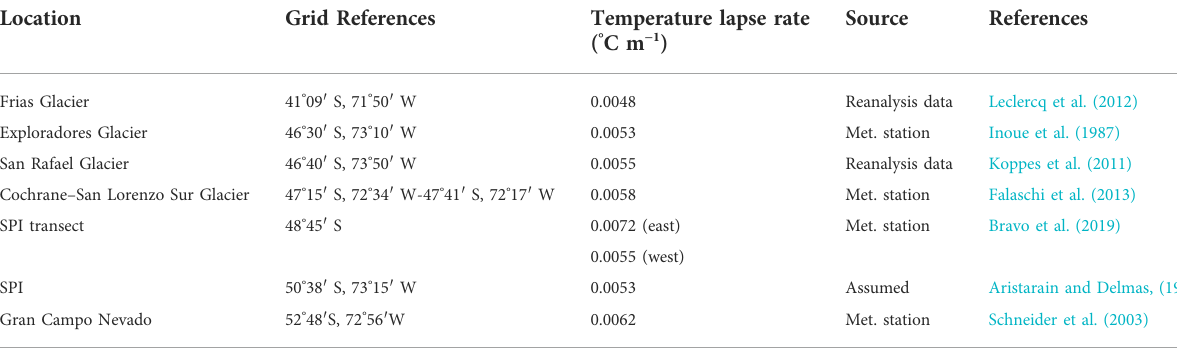
TABLE 1 Observed temperaturelapse rates fromacross Patagonia.Lapse rate from Cochrane toSan Lorenzo Glacier calculated by the authors, using data from Falaschi et al. (2013). SPI is Southern Patagonian Ice fi eld.